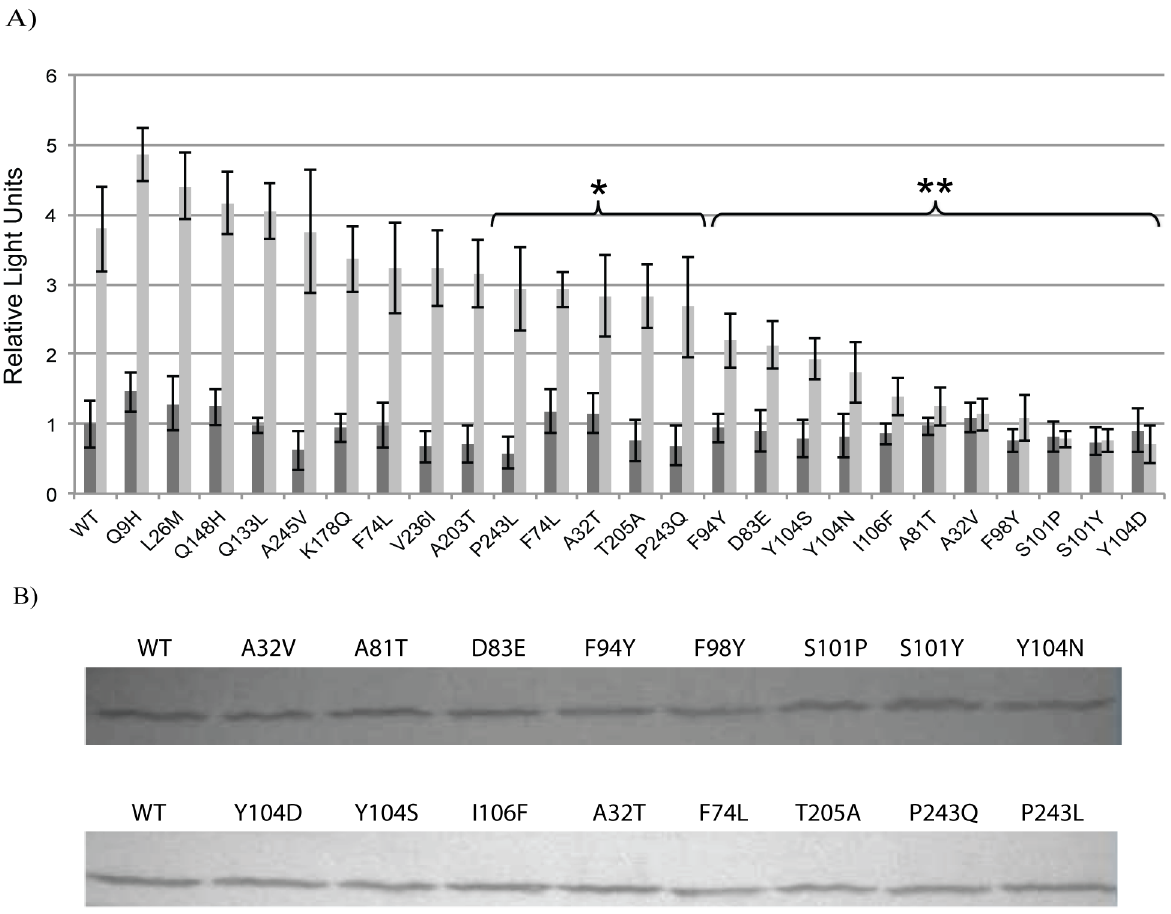
Figure 1. Characterization of EsaR* variants with single amino acid substitutions generated via site-directed mutagenesis. Panel A, Chemiluminescent b -galactosidase assays were performed from two independent experimental samples tested in triplicate with error bars representing the standard deviation of the data, which was normalized to the wild-type control without AHL. Dark grey and light grey bars represent samples without and with AHL, respectively. A statistical comparison of the levels of b -galactosidase produced in the presence of AHL between strains expressing EsaR* variant proteins and the wild-type control is indicated by the brackets highlighting unpaired t test two-tailed P values of , 0.004 (*) or , 0.0001 (**), respectively. Panel B, western immunoblots demonstrating the stability and relative quantities of 28 kDa wild-type EsaR (WT) and EsaR* variants as indicated. Images are representative of experiments performed in duplicate. at a 1:1 ratio in relation to protein concentration. The proteins were rapidly repurified, and bound AHL was extracted. The extracted AHL was then exposed to recombinant E. coli harboring a plasmid that expresses LuxR and contains a gfp reporter gene under the control of P luxI . The in vitro AHL binding experiments revealed that two of the eight variants, D83E and F94Y, retained some ability to bind AHL. The six remaining variants appeared to be deficient in AHL binding (Figure 2). Residues 32, 98, 101, 106 identified during the screen, were predicted to be involved in AHL binding based on amino acid alignments with LasR and TraR [13,14,16]. When the position of these residues is modeled onto a homology model of EsaR, they cluster around the predicted AHL binding pocket (Figure S3). Therefore, the AHL binding assays suggested that the amino acid substitutions at six of the residues (A32V, A81T, F98Y, S101P, Y104D, I106F) directly or indirectly interfered with AHL binding.